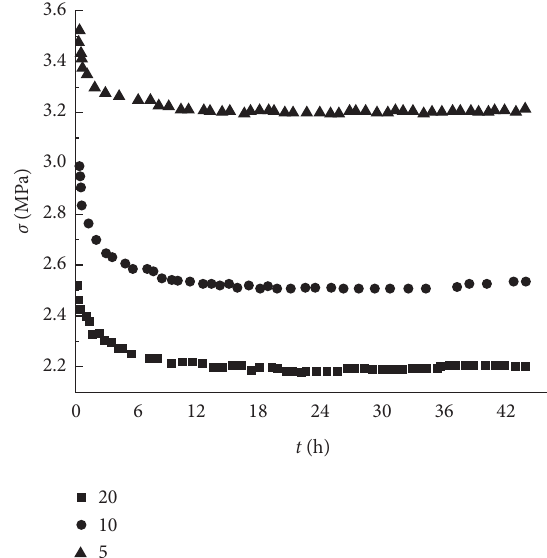
Figure 6: Rock stress relaxation curve by